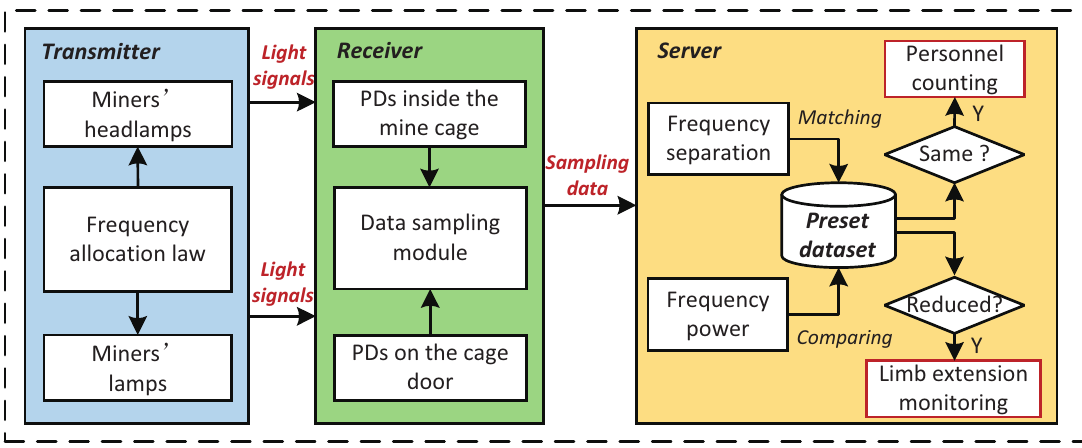
Figure 2. Algorithm